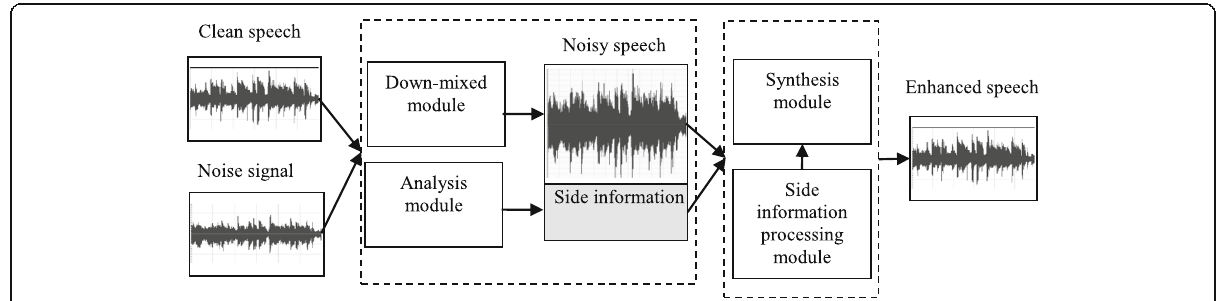
Fig. 2 Block diagram of speech enhancement framework based on the